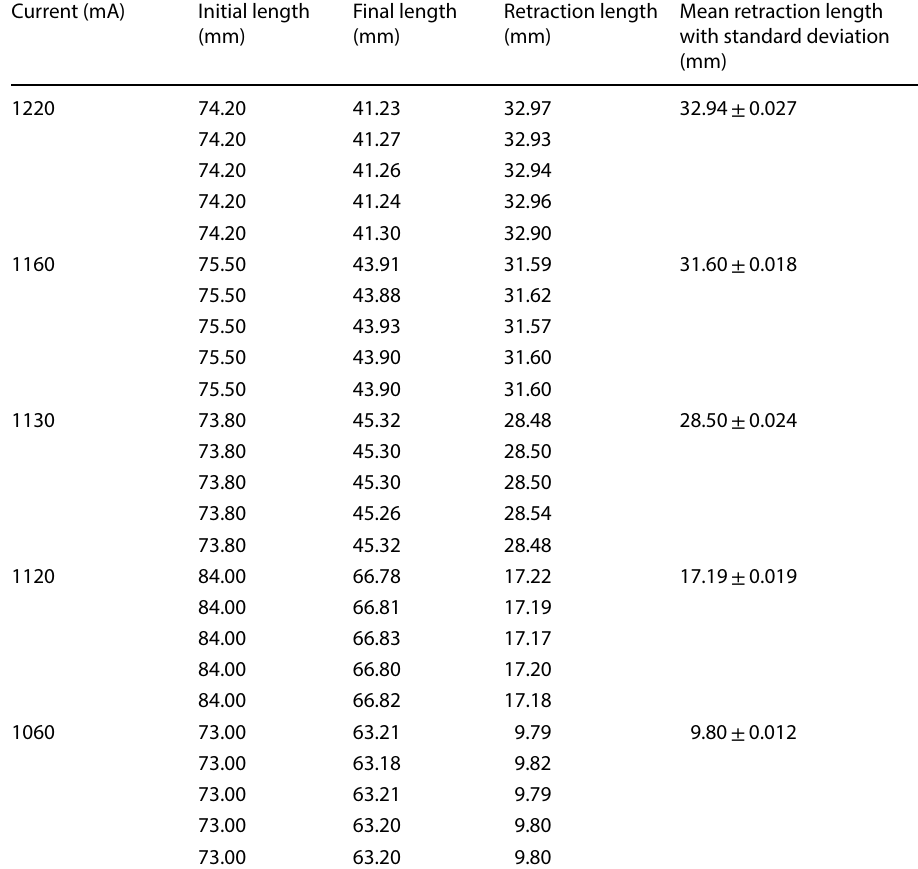
Table 4 Retraction length of SMA spring (in series) at varied direct